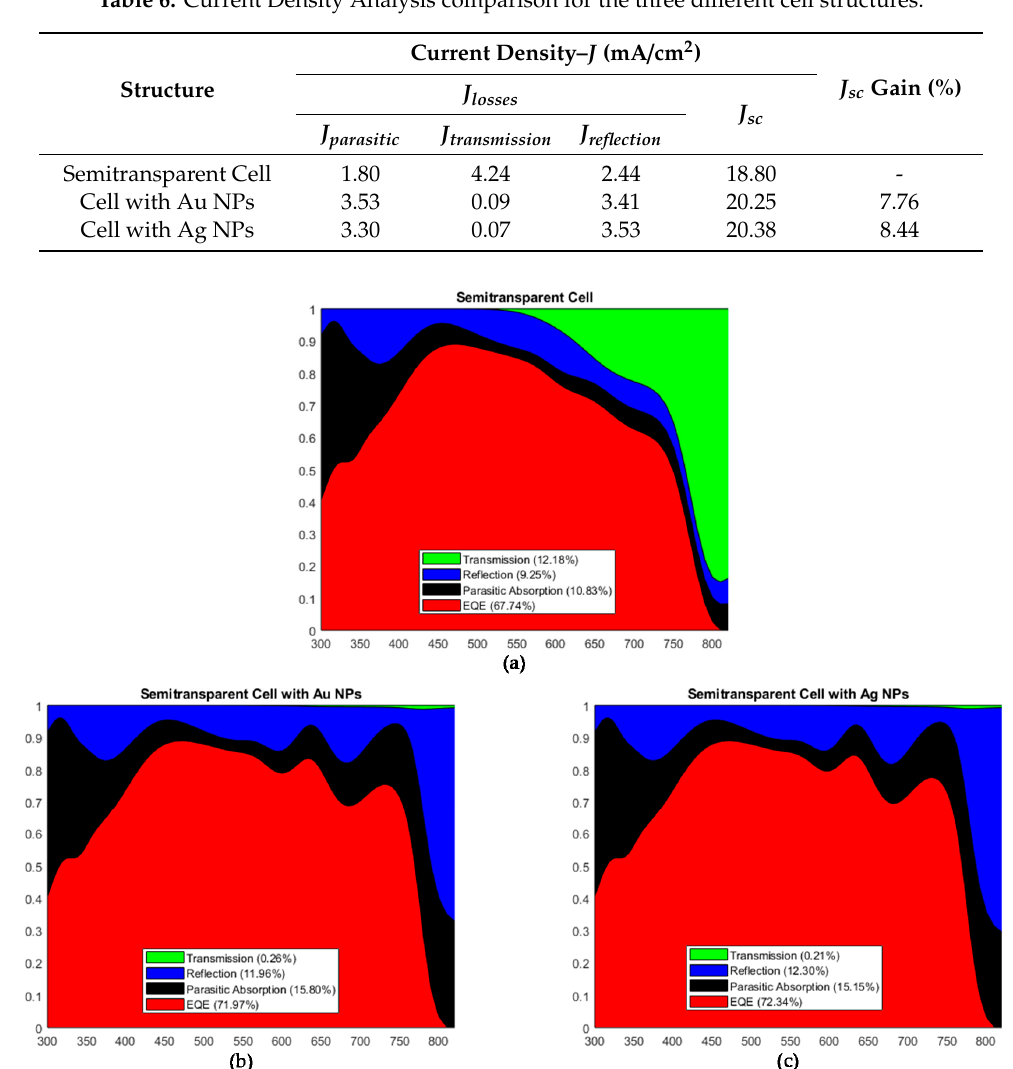
Figure 10. Area plot of the ( a ) semitransparent cell, ( b ) cell with Au NPs, ( c ) cell with Ag NPs, displaying the area covered by the EQE, parasitic absorption, reflection, and transmission.